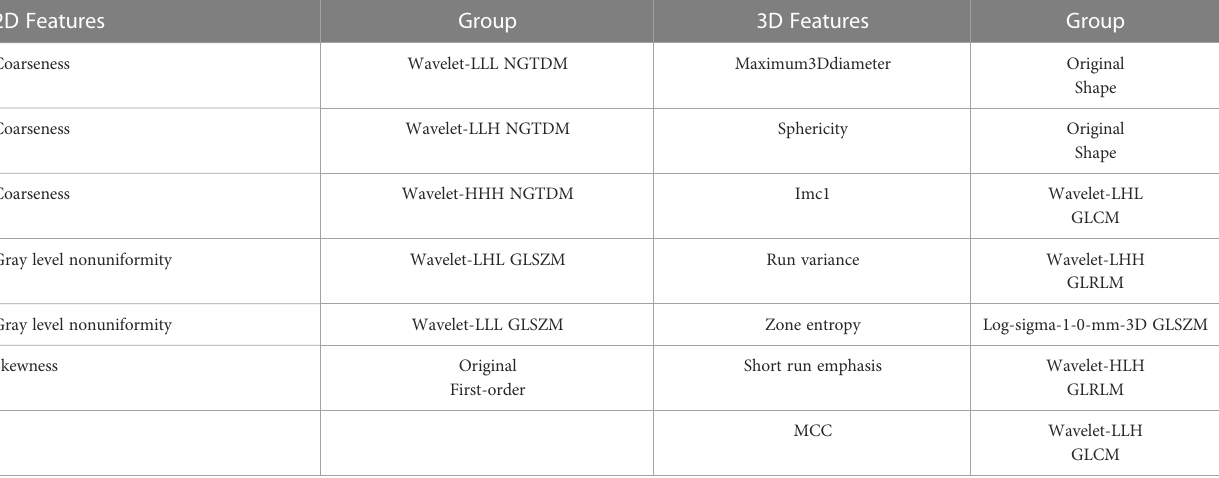
TABLE 2 The selected features and their group.